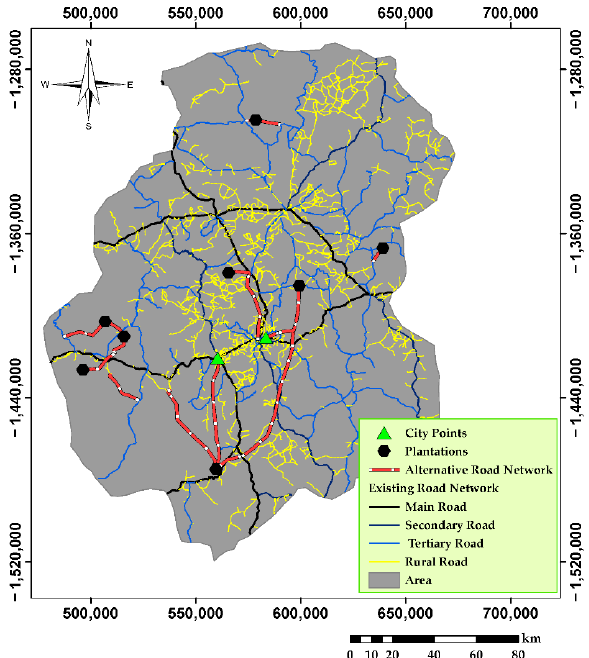
Figure 11. Map of alternative routes based on the results from AHP in relation to tree cover.